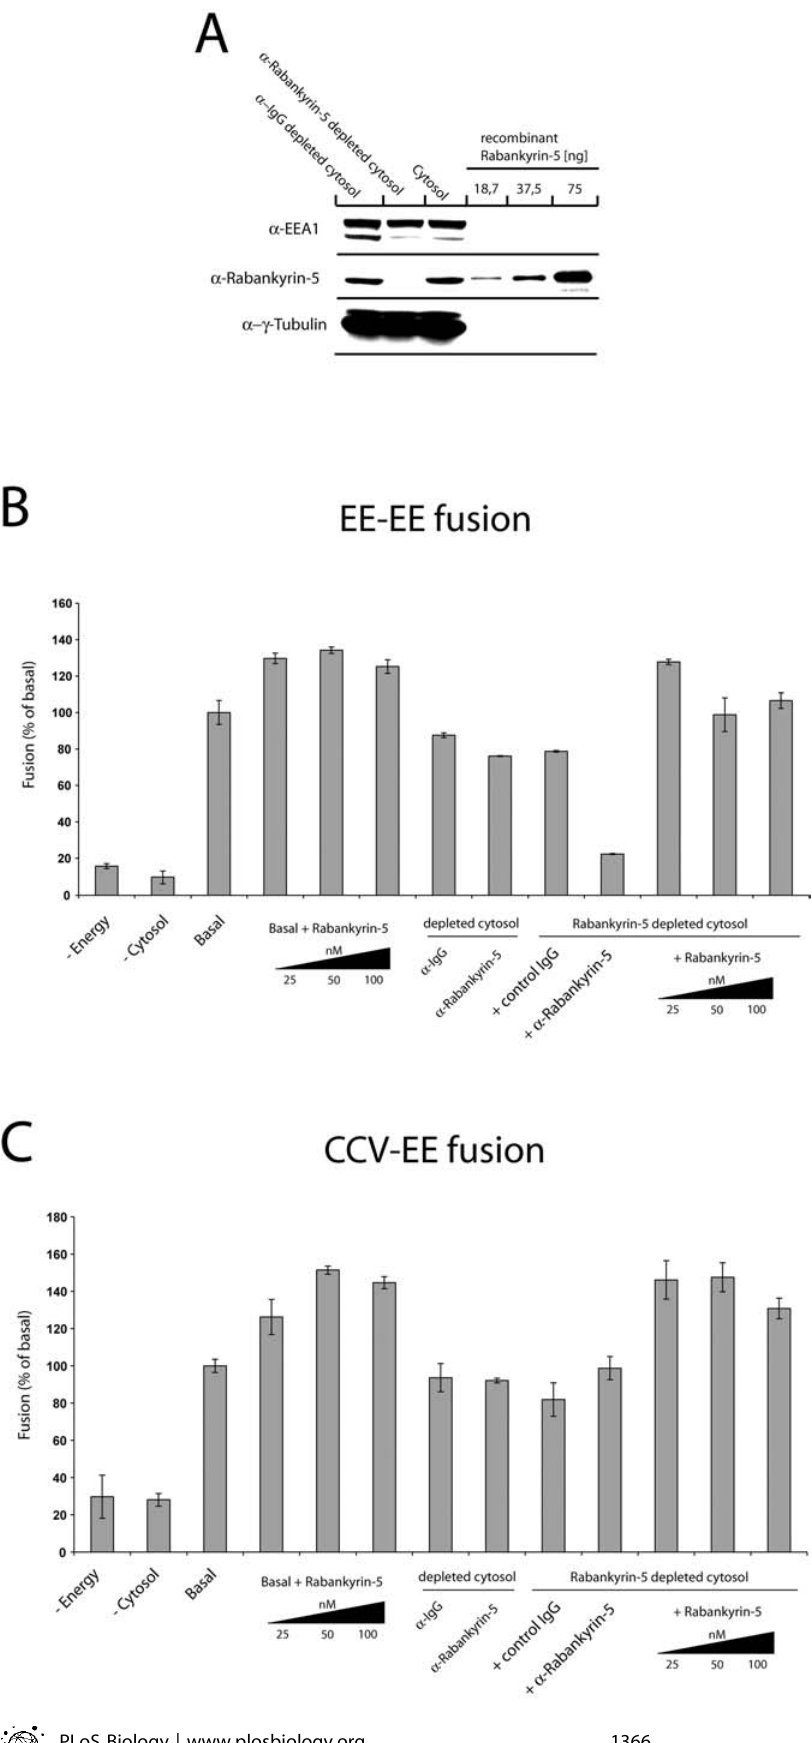
Figure 2. Rabankyrin-5 Stimulates Homo- typic Fusion between Early Endosomes and Heterotypic Fusion between Early Endosomes and CCVs In Vitro (A) Rabankyrin-5 was efficiently immu- nodepleted from HeLa cytosol without affecting the EEA1 concentration. Twenty micrograms of HeLa cell cytosol, either treated with control IgGs and immunodepleted for Rabankyrin-5 or nontreated, was applied to SDS-PAGE and probed for the indicated antigens by Western blotting. Anti- c tubulin was used as a loading control. (B and C) Addition of recombinant Rabankyrin-5 stimulates homotypic and heterotypic fusion. Fusion (B) between early endosomes (EE-EE fusion) and (C) of early endosomes to CCVs (CCV-EE fusion) in vitro was performed in the presence of 3 mg/ml HeLa cytosol and an ATP-regenerating system (basal) and in was immunodepleted for Rabankyrin-5 (columns 8–13) and in addition supple- membrane-associated proteins (column 10). Background fusion activity is dem- onstrated by ATP ( (cid:1) Energy) or cytosol ( (cid:1) Cytosol) omission. DOI: